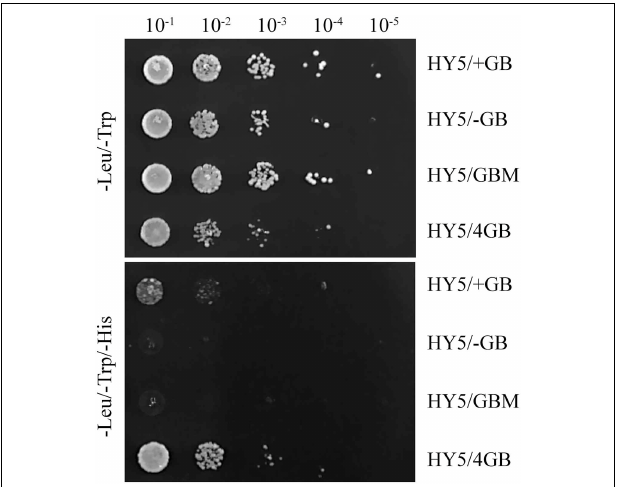
FIGURE 6 | The yeast one-hybrid showed that the QH6 promoter region could bind HY5 in vivo . The QH6 promoter fragment from − 258 to − 425bp upstream of the translation initiation site, including the G-box, was used as the bait ( + GB), and the same fragment with the G-box removed (-GB) or mutated (GBM) was used as the control. A sequence containing four consecutive repeats of the G-box motif (4 GB) was also synthesized to test enhanced interactions. pHIS2.1 harboring +GB, -GB, GBM, or 4GB was co-transformed with pGADT7-HY5. Cells were grown in liquid medium to OD 600 = 0 . 1 (10 − 1 ) and diluted in a 10 × series (10 − 2 to 10 − 5 ). At each dilution, 5 µ L was spotted on media selecting for the existence of both plasmids (-Leu/-Trp double drop-out) or the interaction (-Leu/-Trp/-His triple drop-out).